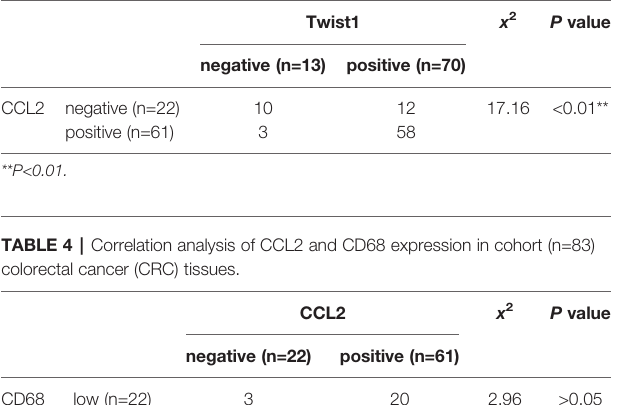
TABLE 3 | Correlation analysis of Twist1 and CCL2 expression in cohort (n=83) colorectal cancer (CRC) tissues.